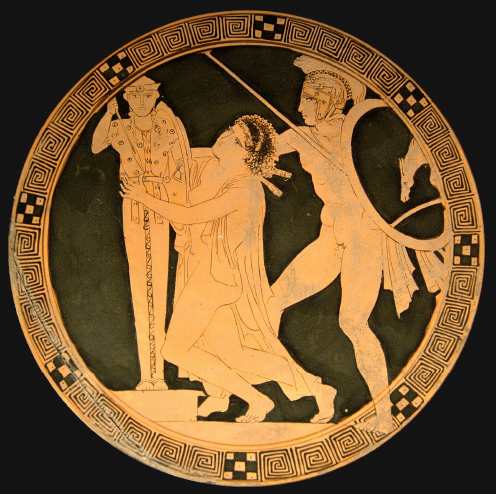
Figure 4. Cassandra abducted by Ajax the lesser. Tondo of an Attic red-figure cup, ca. 440–430